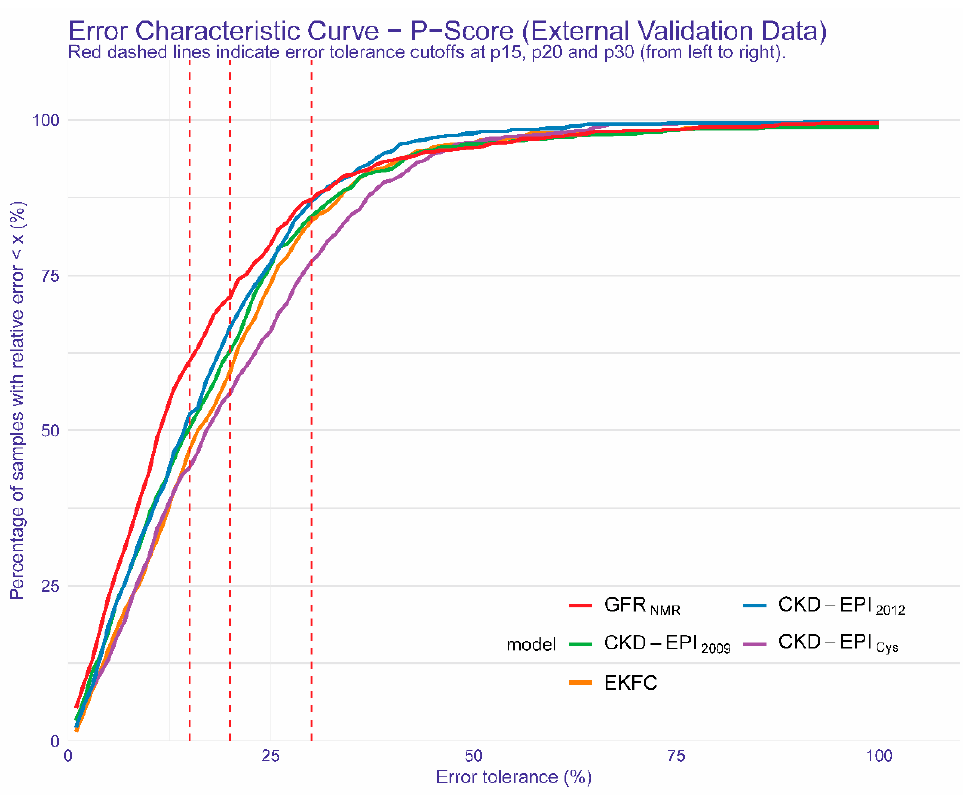
Figure 2. Regression Error Characteristic Curve for all error tolerance Px values for GFR NMR , CKD ‐ EPI 2009 , EKFC, CKD ‐ EPI Cys , CKD ‐ EPI 2012 . Px denotes the percentage of eGFR values within x% of measured GFR. The red dashed lines indicate error tolerance cutoffs of (from left to right) P15, P20 and P30, respectively. The y ‐ axis shows the corresponding percentage of samples within the given error tolerance Px value on the x ‐ axis. Colored curves represent the results of the different equations.